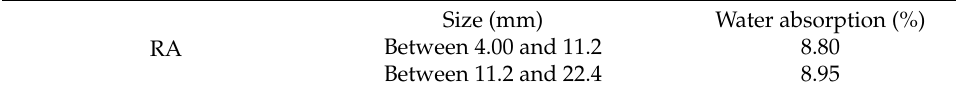
Table 1. The initial properties of RAs